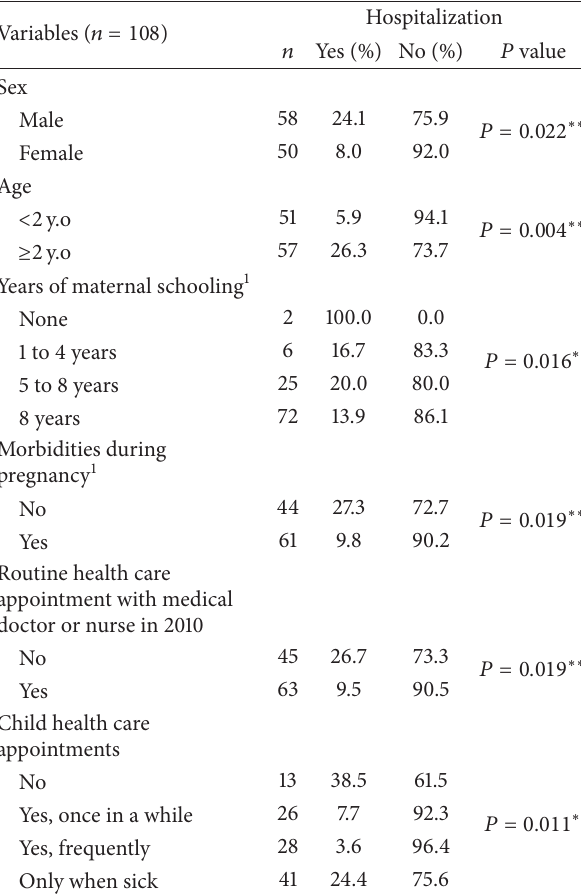
Table 7: Factors associated with diarrhea in the previous 30 days in children aged under 5 years, I˜napari, 2011.